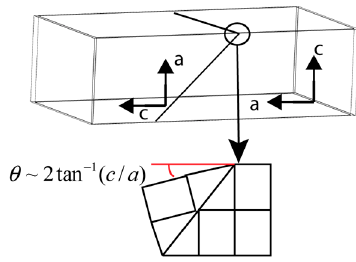
Figure 10. Schematic illustration of the misorientation angle between two domains separated by a non-180° domain wall in a tetragonal crystal.